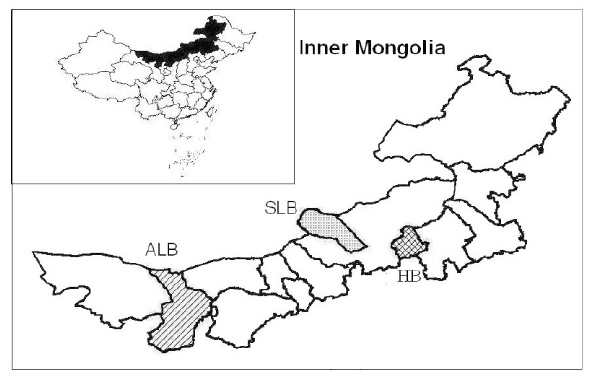
Fig. 1. Locations of the case study sites. ALB = Alxa Left Banner; HB = Hexigten Banner; SLB = Sonid Left